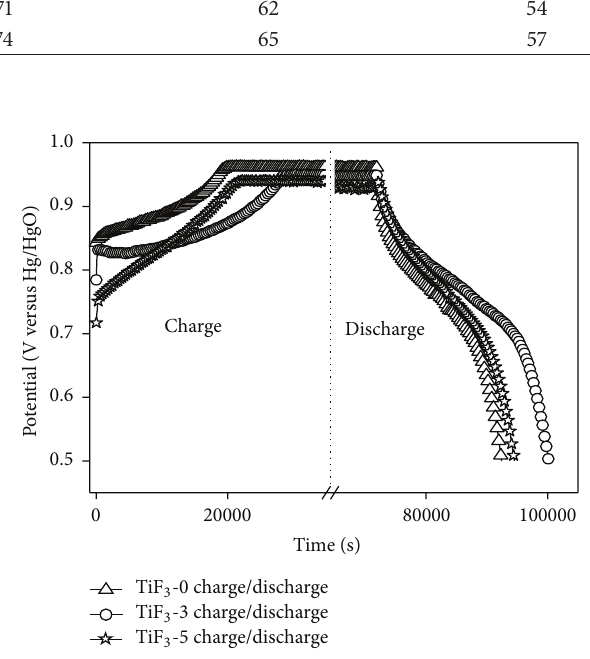
Figure 2: Evolution of the discharge capacity of milled La 2 Mg 17 + 150 wt% Ni + 𝑦 wt% TiF 3 ( 𝑦 = 0, 3, 5 ) composites with the cycle number.